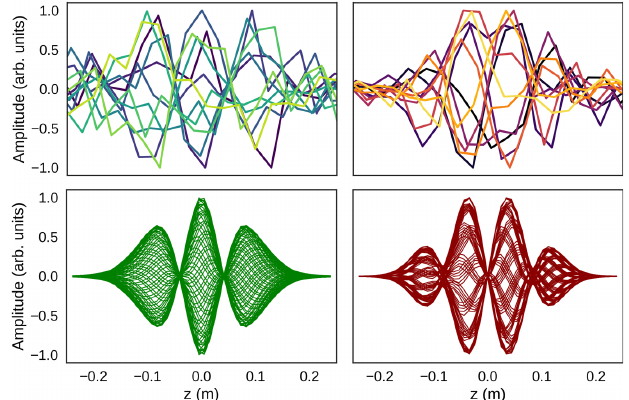
FIG. 8. Comparison of the two modes observed in the machine (top) and in P y HEADTAIL simulations (bottom) without (left) and with (right) the effects from Q 00 . They correspond to the working points labeled (a) and (b), respectively (compare Fig.